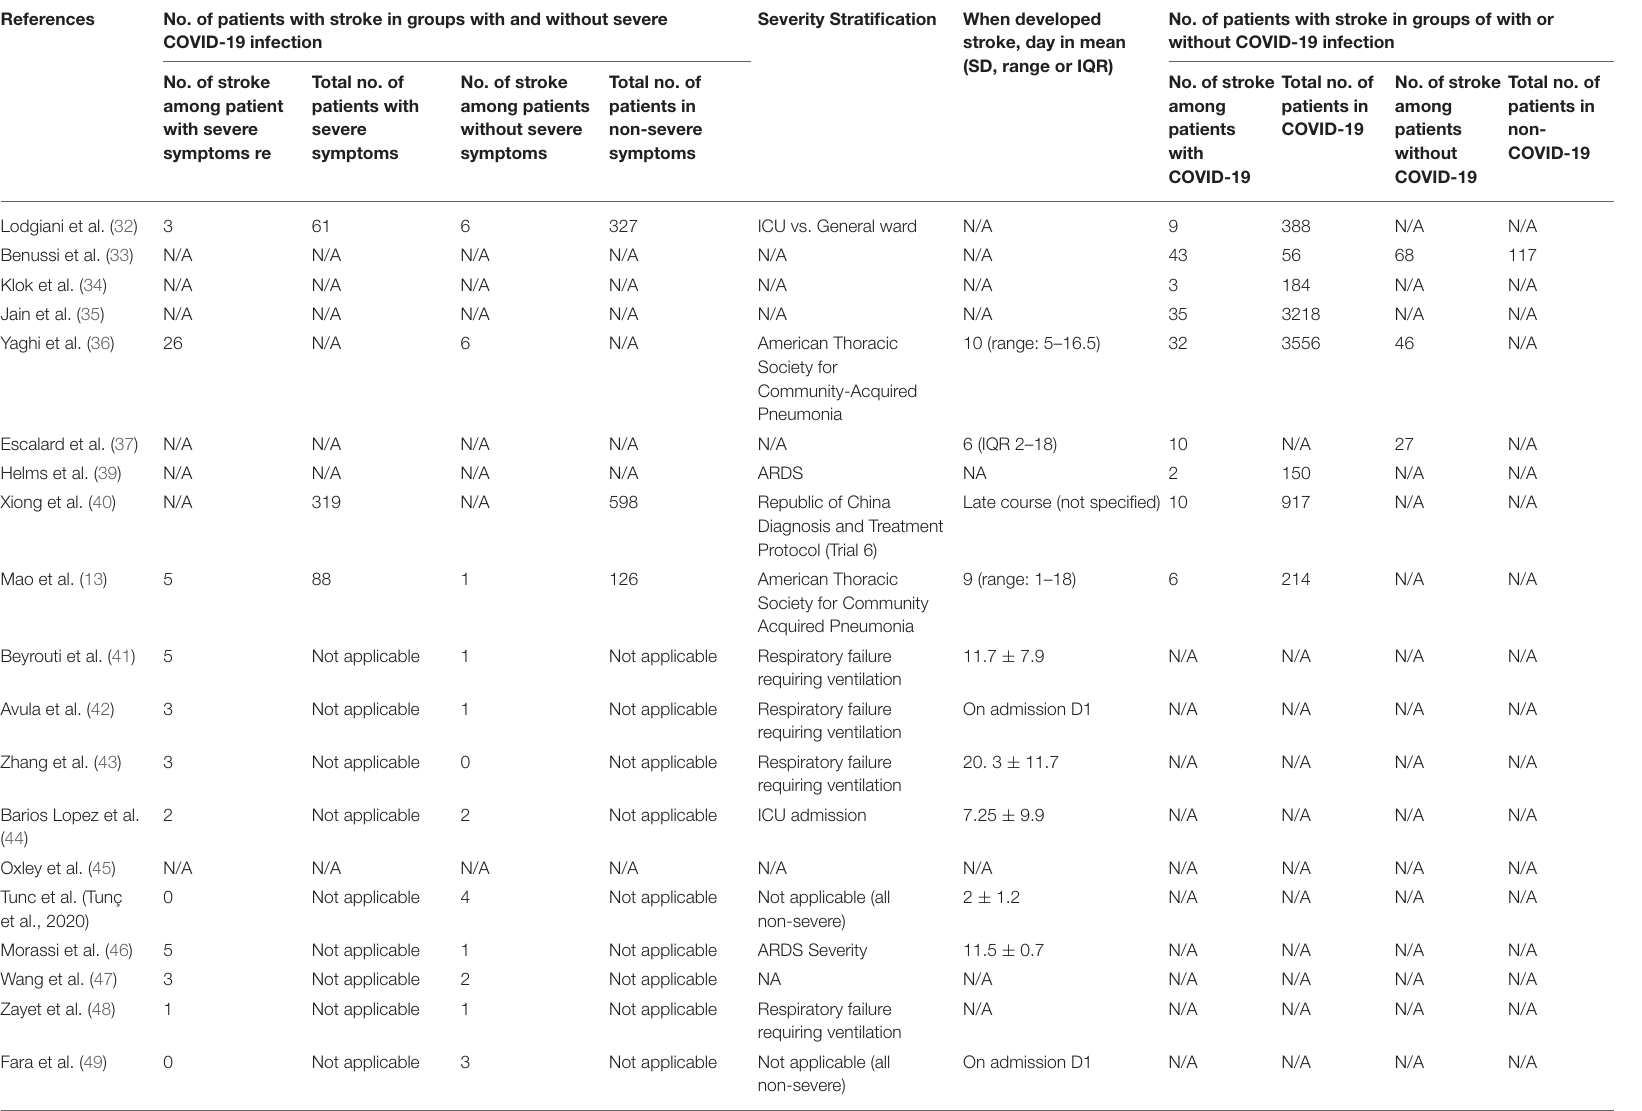
TABLE 2 | Information on the number of stroke patients in groups with and without severe COVID-19 infection as well as with and without COVID-19